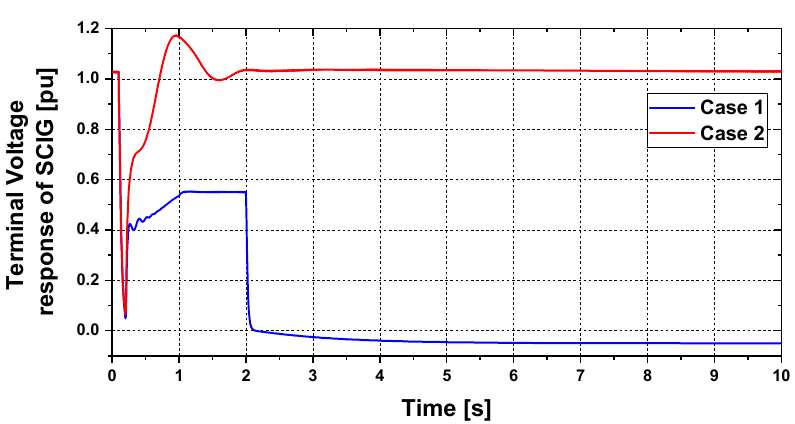
Figure 14. Rotor speed response of SCIG. . Figure 15. Real power response of SCIG.